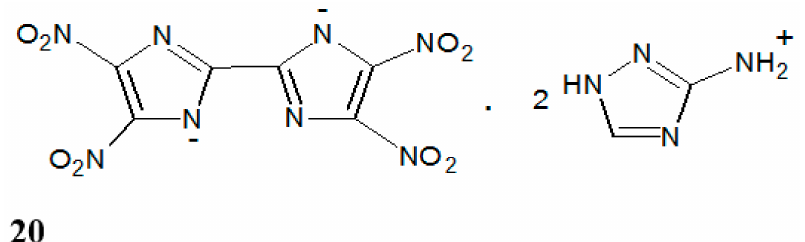
Figure 12. The structure of 3-amino-1,2,4-triazolium 4,4 (cid:48) ,5,5 (cid:48) -tetranitro-2,2 (cid:48) -biimidazolate ( 20